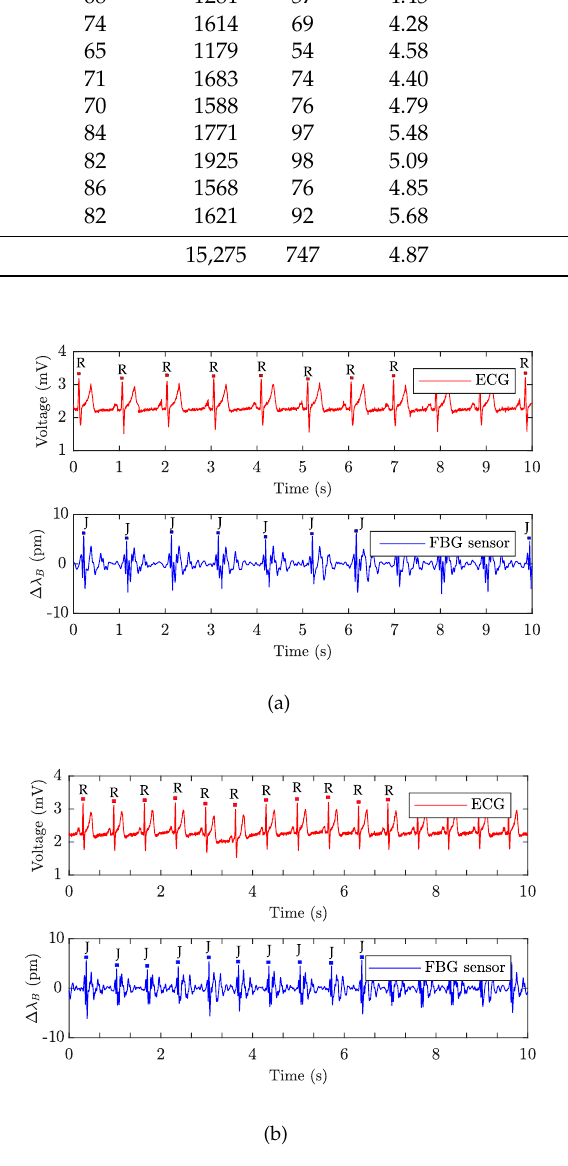
Figure 13. Ten-second long sample recordings of the heart activity; ( a ) M1 volunteer, and ( b ) F1